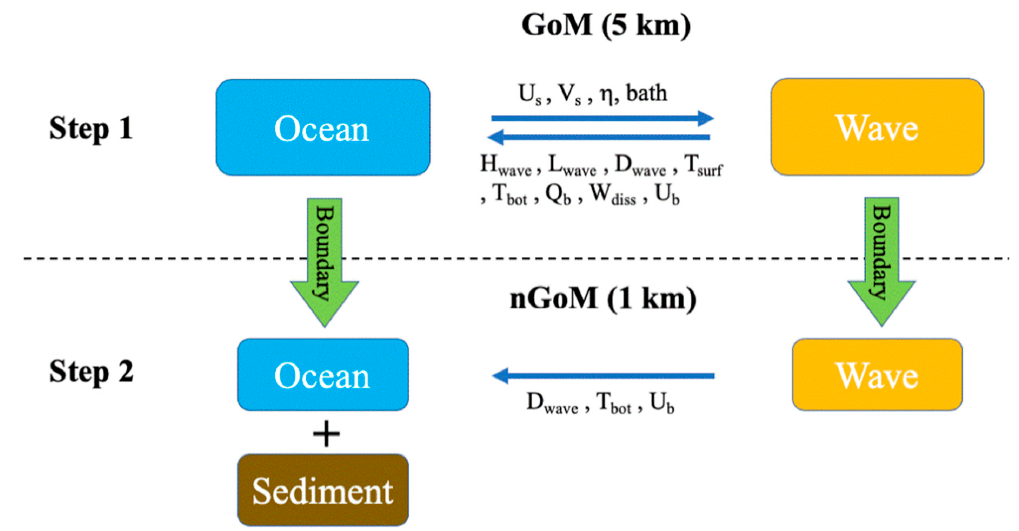
Figure 2. Flow chart of GoM and nGoM simulation. In step 1 we coupled ocean model (ROMS) and wave model (SWAN) for the GoM simulation. In step 2 (nGoM), ocean and wave simulations were conducted independently and the wave model provided inputs (D wave , T bot , U b ) for ocean and sediment simulation (U s V s : Sea surface current velocity; η : Water level; bath: Bathymetry; H wave : Significant wave height; L wave : Wave length; D wave : Wave direction; T surf : Wave period at the surface; T bot : Wave period at the bottom; Q b : Percent breaking; W diss : Energy dissipation; U b : Bottom wave orbital velocity).